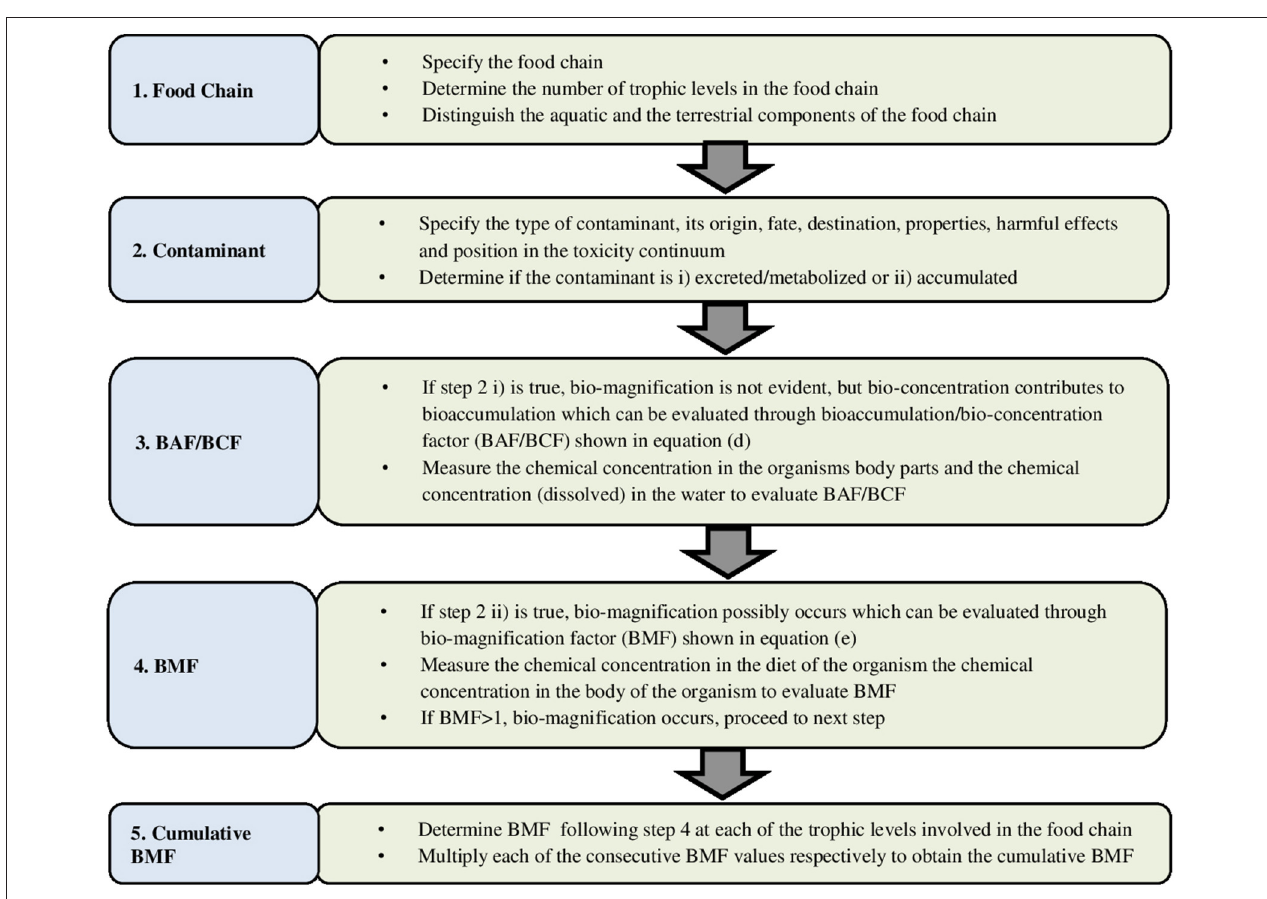
FIGURE 2 | Protocol to evaluate